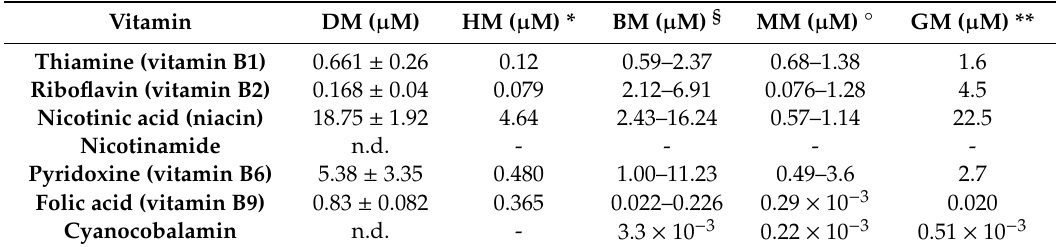
Table 2. Content of B-vitamins in donkey milk (DM) and comparison with human milk (HM), bovine milk (BM), mare milk (MM) and goat milk